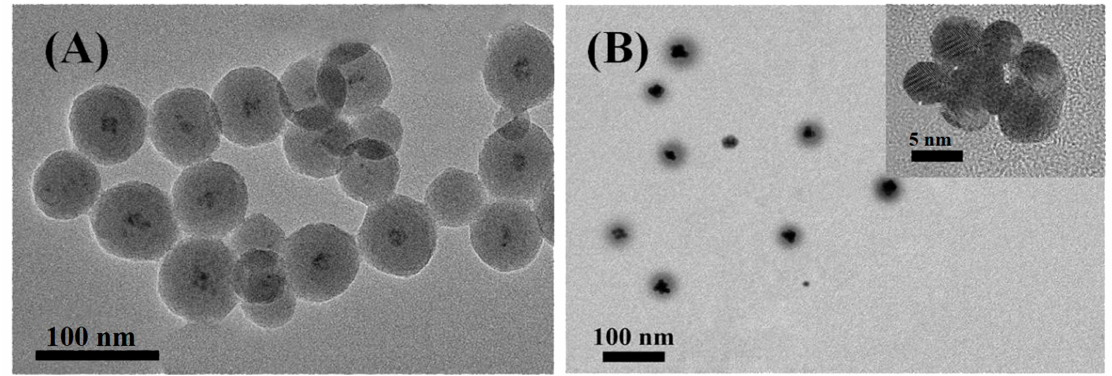
Figure 3. TEM images of CdSe / ZnS@M4-1 with di ff erent M4-1 / QDs ratio: ( A ) 1: 0.1 and ( B ) 1:10. (insert: HRTEM of single CdSe / ZnS@M4-1, the scale bar refers to 5